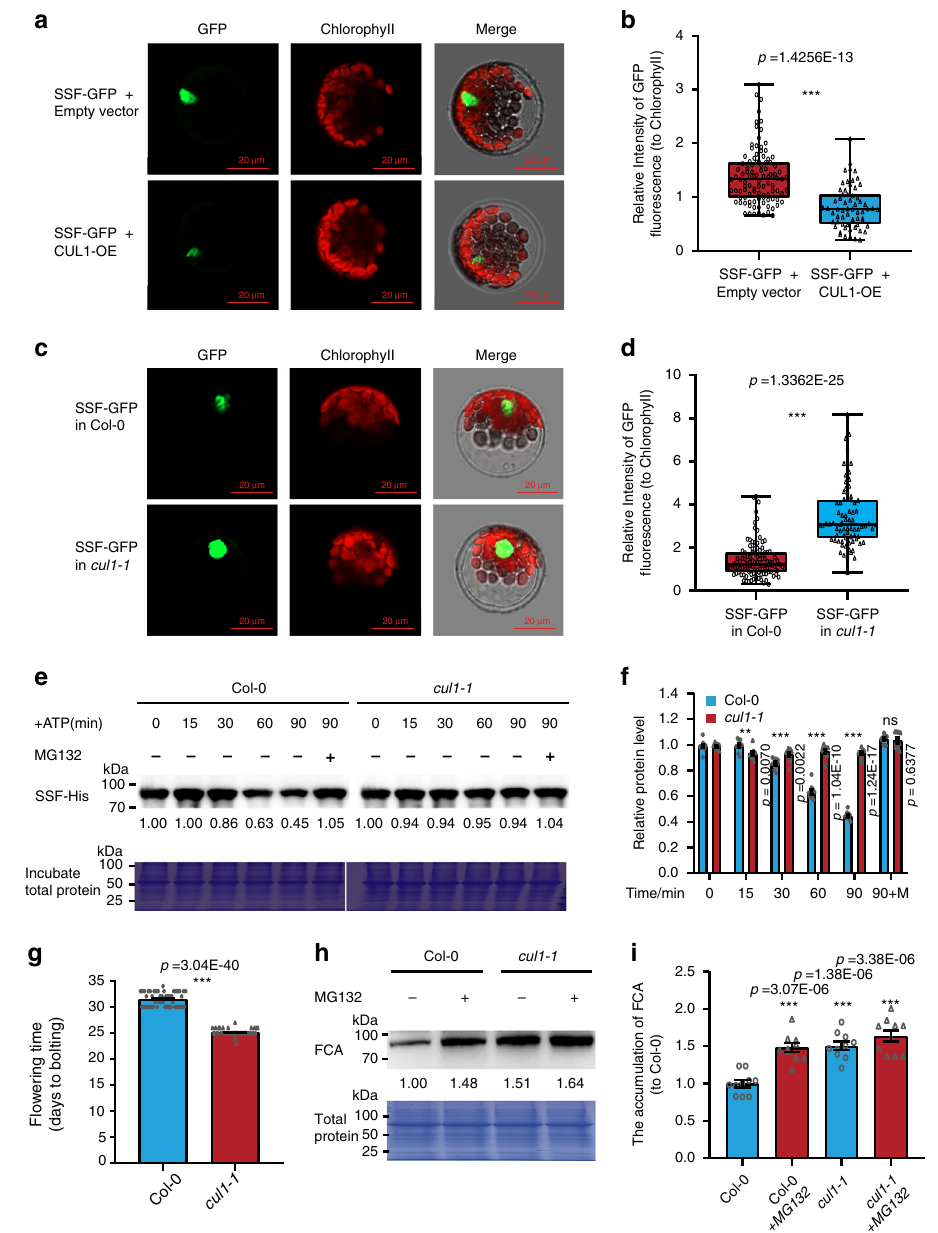
Fig. 5 CUL1 could promote SSF degradation. a , b The SSF-GFP signal was downregulated by overexpression of CUL1 ( CUL1-OE ) in Arabidopsis protoplasts. The GFP signal was quanti fi ed and normalized to chlorophyll fl uorescence in 102 cells for SSF-GFP + Empty vector and 63 cells for SSF-GFP + CUL1-OE, and each type was randomly collected under confocal microscopy ( b ). Observation and quanti fi cation of each cell were performed under the same set of confocal parameters and at the same scale. c , d The SSF-GFP signal was upregulated in cul1-1 protoplasts compared with Col-0 protoplasts. The SSF-GFP signal from 77 cells of each type was quanti fi ed and normalized to chlorophyll fl uorescence ( d ). The results in ( a – d ) were con fi rmed at least three times. Bar: 20 µ m. e , f The degradation of SSF was slower in cul1-1 than Col-0 in the cell-free protein degradation assay. Recombinant puri fi ed His-SSF was incubated in equal amounts of total proteins extracted from 14-day-old wild-type Col-0 and cul1-1 seedlings in the presence of ATP. Representative images are shown in ( e ), and relative protein levels are shown in ( f ). His-SSF was detected with an anti-His antibody. Total protein was used as a loading control. In ( f ), n = 10 independent replicates. g Comparison of fl owering time between cul1-1 and wild-type Col-0 under long-day growth conditions ( n = 48). h , i FCA is more enriched in cul1-1 than Col-0. Total protein was extracted from 14-day-old Col-0 and cul1-1 seedlings. FCA was detected with an anti-FCA antibody. Total protein was used as a control. Representative images are shown in ( h ), and relative protein levels are shown in ( i ). In ( i ), n = 10 independent replicates. These experiments were repeated at least three times, and consistent results were obtained. In ( b , d ), Box plot: lower vertical bar = sample minimum, lower box = lower quartile, middle line = median, upper box = upper quartile, upper vertical bar = sample maximum, single points = outliers. In ( f , g , i ), data are presented as mean ± SEM, and asterisks indicate signi fi cant differences (* p < 0.05; ** p < 0.01; *** p < 0.001, ns, not signi fi cant; two-tailed unpaired t test). Source data are provided as a Source data fi